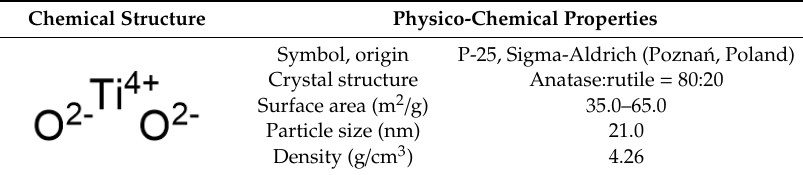
Table 2. Physico-chemical characteristics of TiO 2 .